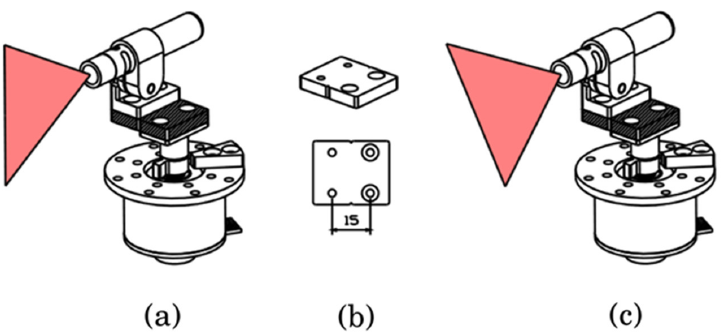
Figure 12. Experiment setup, ( a ) ill-posed condition ( α ill ), ( b ) displacement part, and ( c ) well-posed condition ( α well ). Table 1. Comparison between our system and the commercial sensor (SR305).